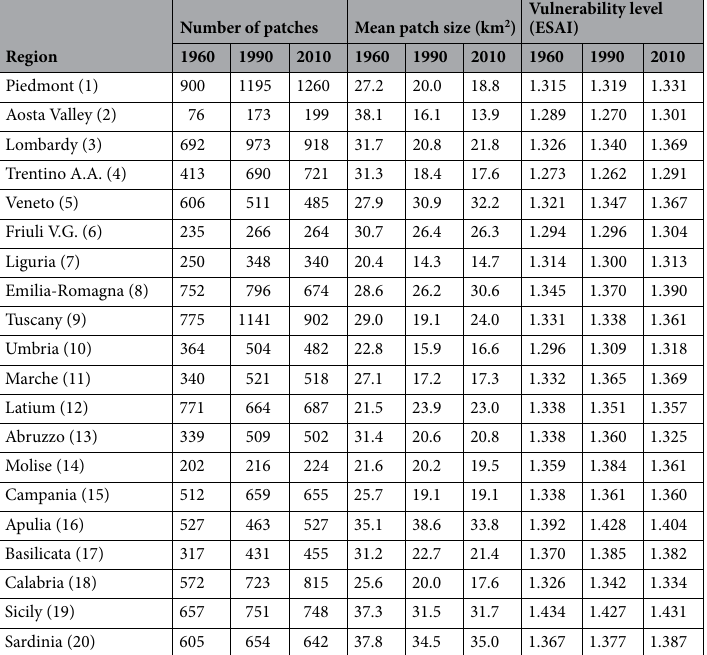
Table 2. Selected variables describing the spatial configuration of the Italian landscape based on three vulnerability classes (‘unaffected’, ‘fragile’, ‘critical’) by administrative region and year (the ID code of each region is reported in